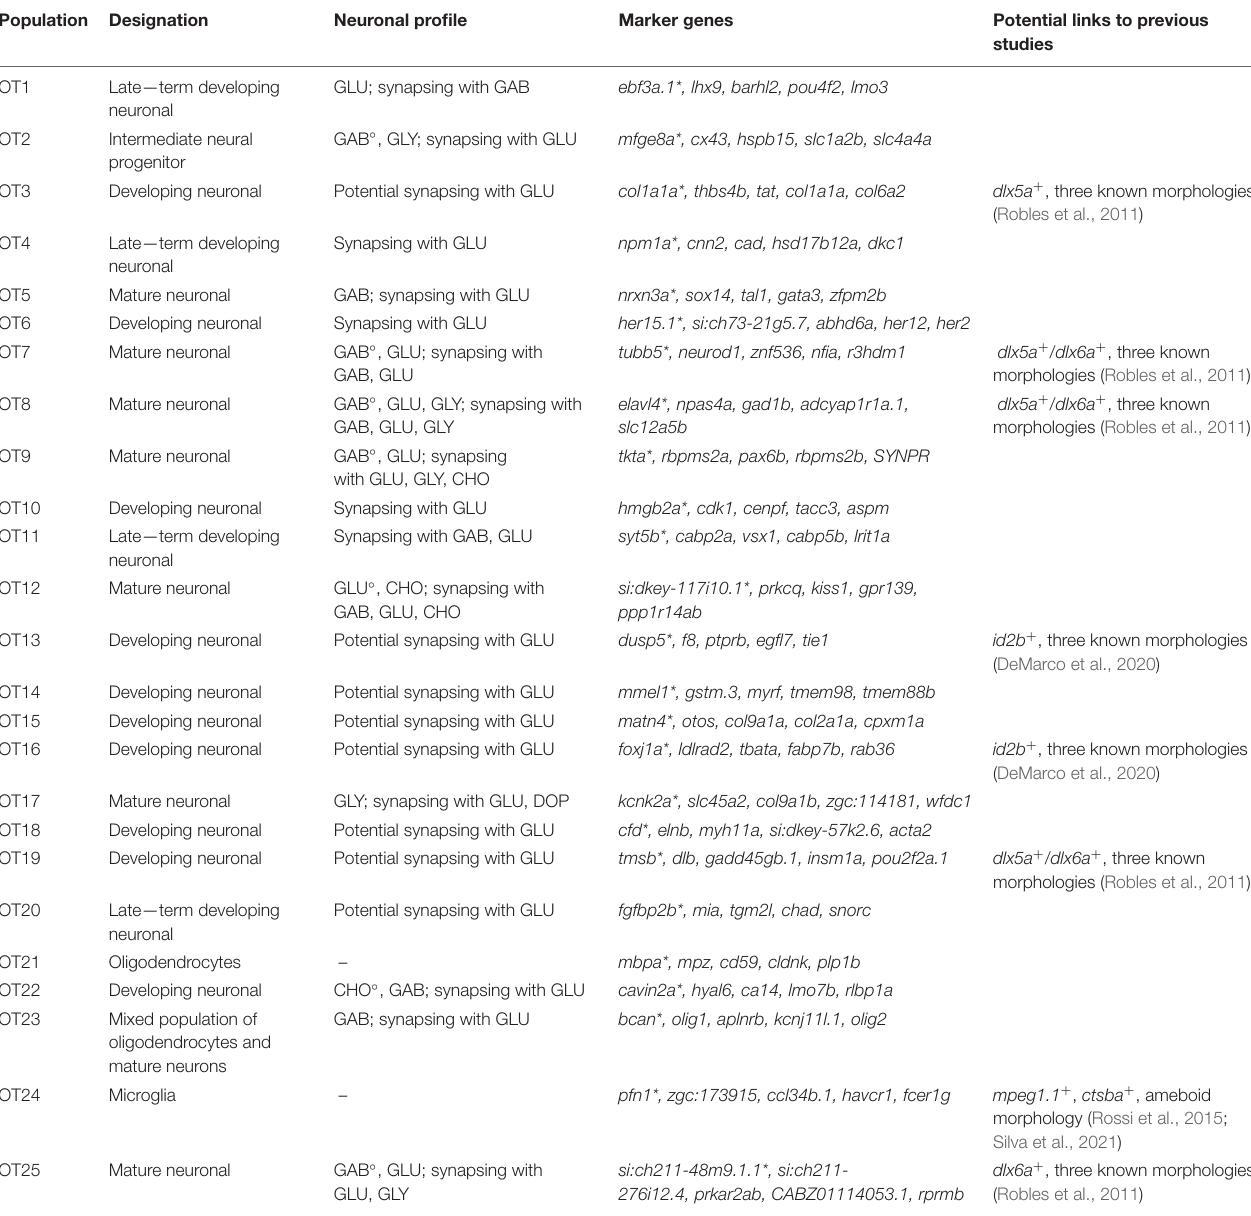
TABLE 1 | Summary of 25 transcriptionally distinct tectal cell